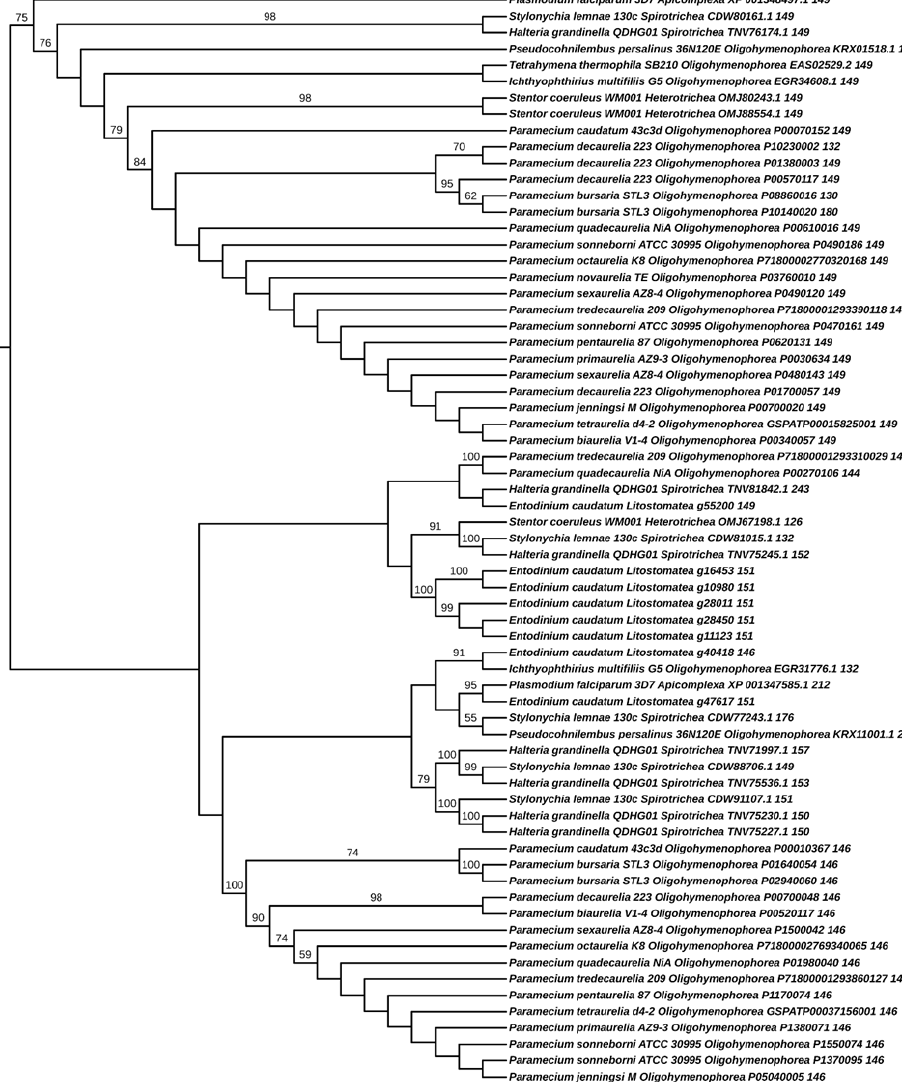
Figure 2. Phylogenetic tree of CaM. Protein sequences from orthogroup OG0001068 were aligned using MAFFT [126]. Alignment file was used with IQ-TREE [127] for tree reconstruction. LG + G4 was the best model selected by IQ-TREE. An Ultrafast Bootstrap approximation with 1000 replicates was used to estimate the node support. However, only bootstrap values higher than 51% are shown. Branch lengths were not considered in order to simplify the tree. The inferred tree was drawn with iTOL (see Figure 1). This tree was rooted so that the two P. falciparum sequences were separated from each other, instead of using them as outgroups. For each species, the full name, strain, Class to which each species belongs (except for P. falciparum , for which the Phylum was used instead of the Class), database accession number, and amino acids size are shown from left to right, respec- tively.